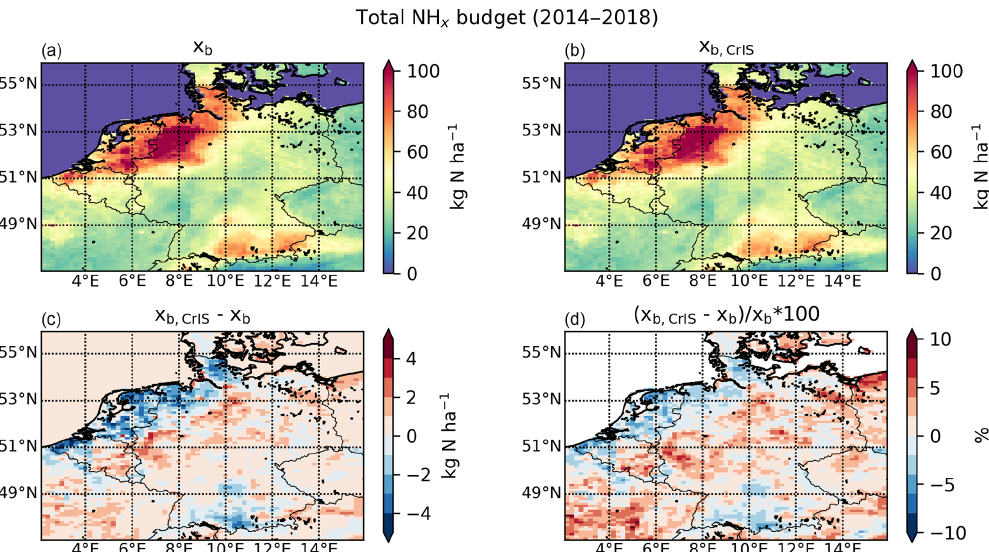
Figure 5. The total NH x deposition from 2014 to 2018 from the (a) default background run ( x b ) and the (b) background run with CrIS-based NH 3 time factors ( x b , CrIS ) and their (c) absolute and (d) relative